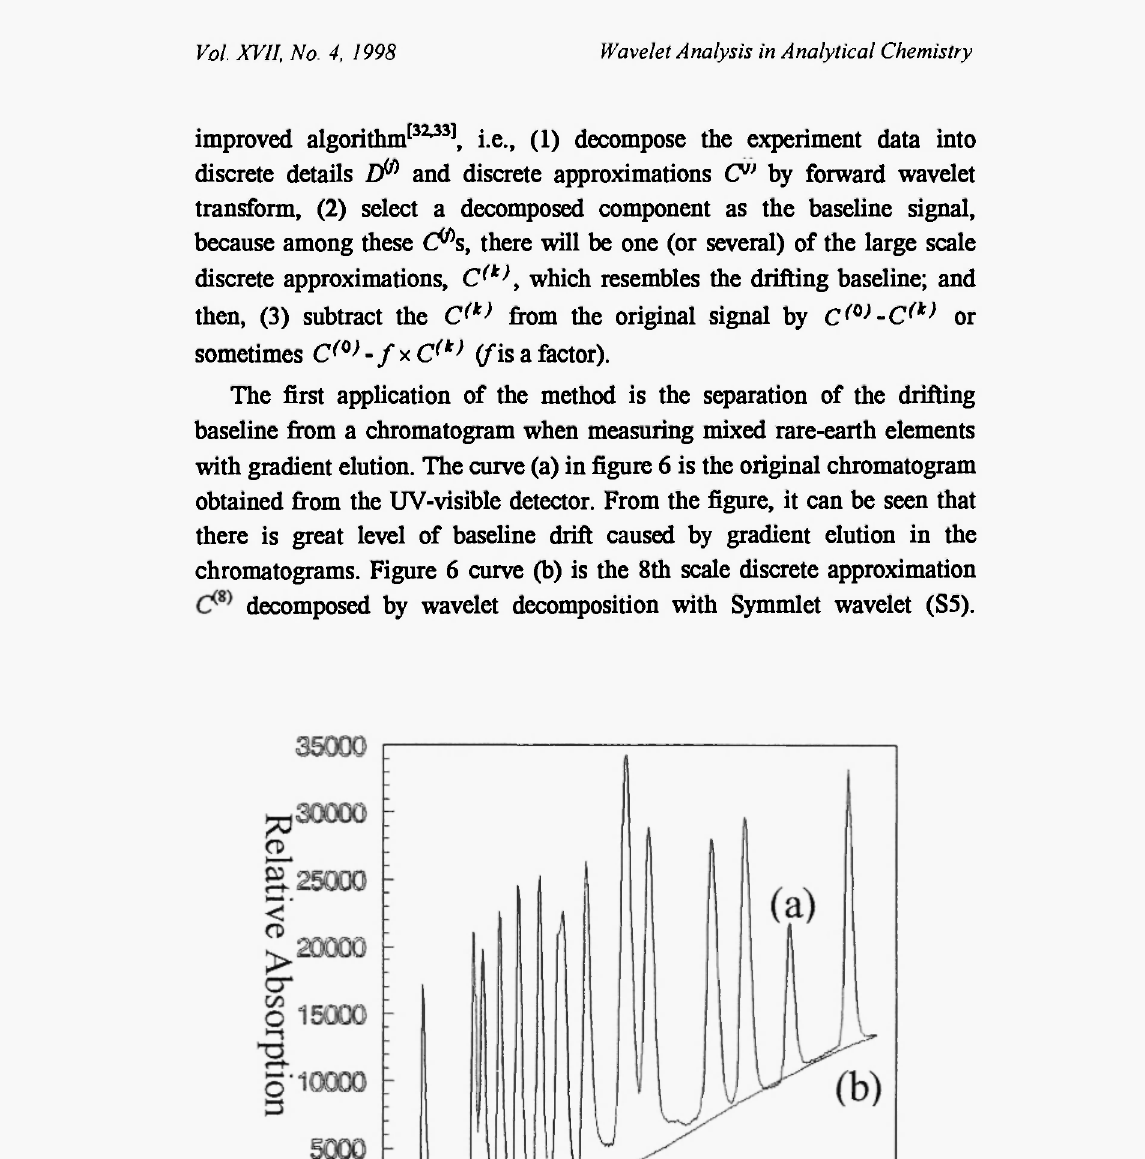
Fig. 6: (a)Chromatogram with drifting baseline (b)Baseline component obtained by wavelet